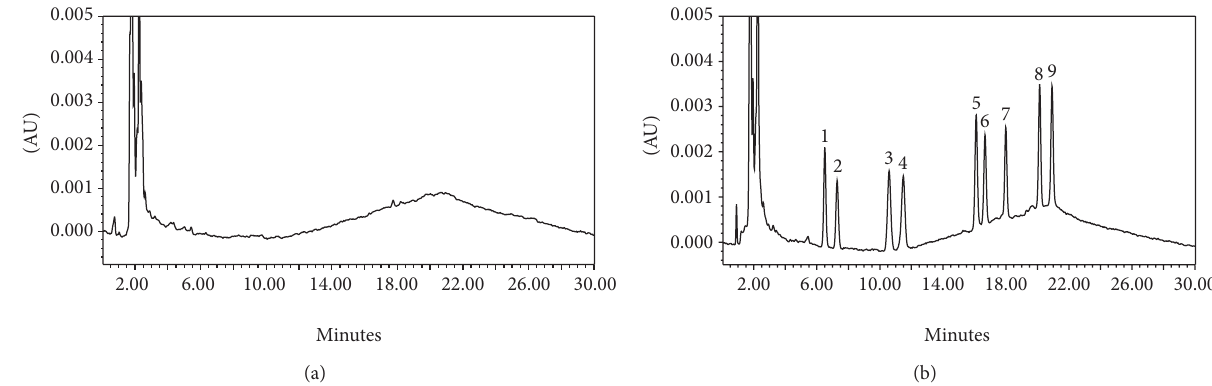
Figure 3: Chromatograms obtained after solid-phase extraction. (a) seawater sample, (b) seawater sample spiked at 2 𝜇 g L −1 . Target com- pounds are numbered as follows: (1) simazine, (2) cyanazine, (3) simetryn, (4) atrazine, (5) ametryn, (6) propazine, (7) terbuthylazine, (8) prometryn, and (9)